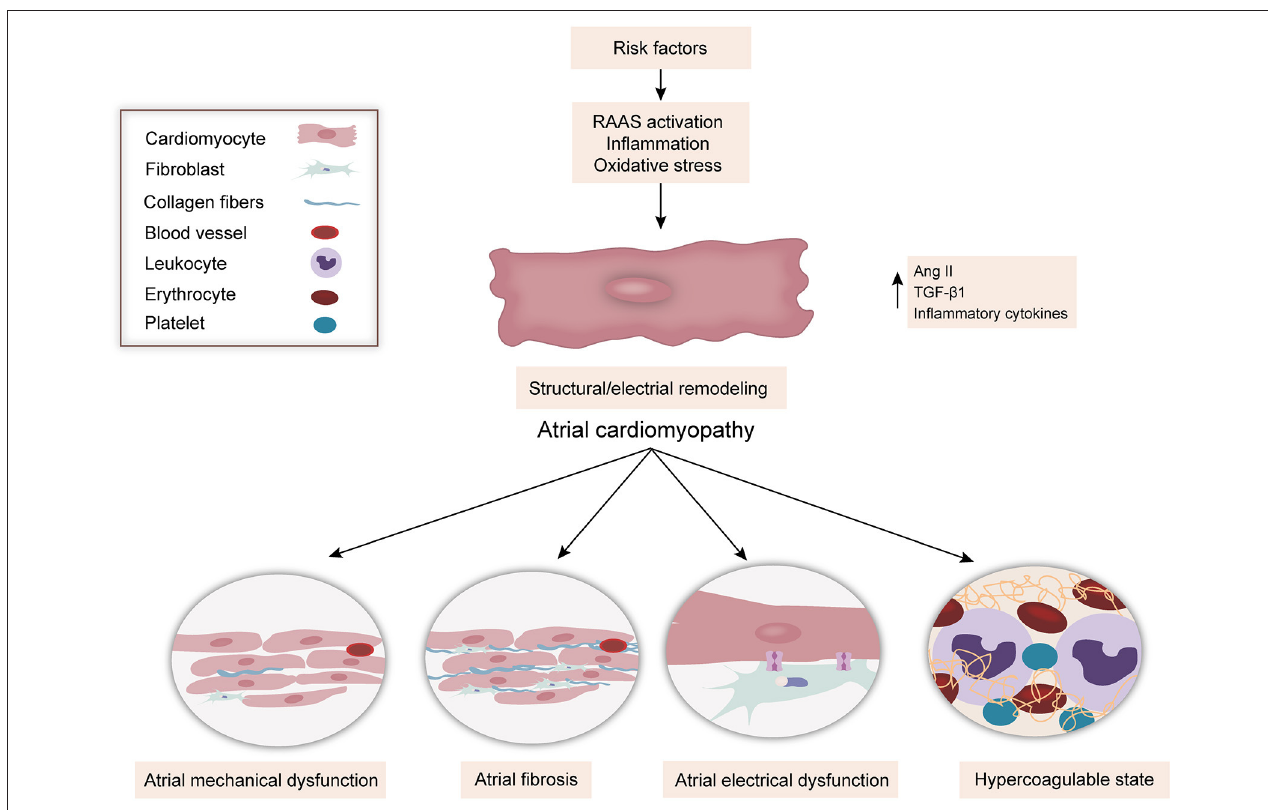
FIGURE 2 | The classification of atrial cardiomyopathy. Multiple risk factors contribute to atrial injury which leads to atrial fibrosis, atrial mechanical dysfunction, atrial electrical dysfunction, and hypercoagulable state. Renin–angiotensin–aldosterone system, RAAS; Ang II, angiotensin II; TGF- β 1, transforming growth factor- β 1.